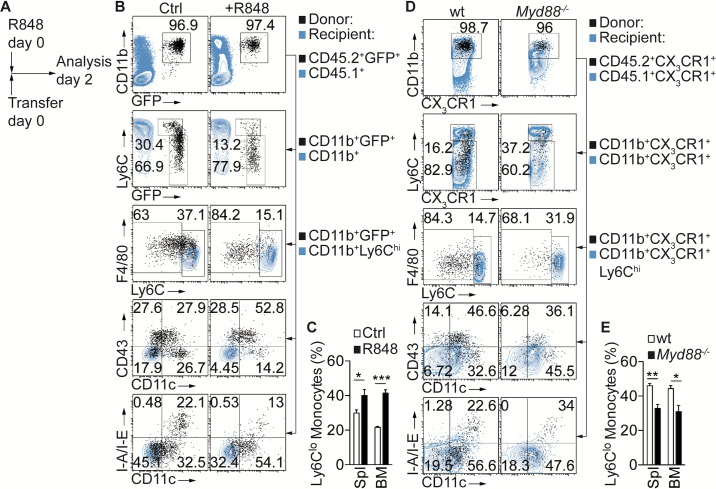
Inflammatory conditions enhance monocyte conversion in vivo.(A–E) Adoptive transfer and flow cytometry analysis of BM CD45.2+ Ly6Chi monocytes in control or R848 injected CD45.1+ congenic recipients: (A) Experimental setup is depicted; (B) Flow cytometry plots showing the progeny of transferred CD45.2+CD11b+Ly6ChiCX3CR1-GFP+ (GFP+) cells in black and recipient CD45.1+ (1st row), CD45.1+CD11b+ (2nd row) or CD45.1+CD11b+Ly6Chi cells (3rd −5th rows) in blue; (C) Frequency of donor-derived Ly6Clo monocytes pooled from two independent experiments (n = 5). (D, E) R848-enhanced conversion is Myd88 dependent in vivo. (D) Flow cytometry plots showing transferred CD45.2+CX3CR1+ wt or Myd88-/- cells in black and recipient CD45.1+CX3CR1+ (1st row), CD45.1+CX3CR1+CD11b+ (2nd row) or CD45.1+CX3CR1+CD11b+Ly6Chi cells (3rd −5th rows) in blue. All recipient mice which received wt or Myd88-/- donor cells were treated with R848; (E) Frequency of donor-derived Ly6Clo monocytes pooled from two independent experiments are shown (n = 4/5). (C, E) *p<0.05, **p<0.01, ***p<0.001; Student’s t-test.